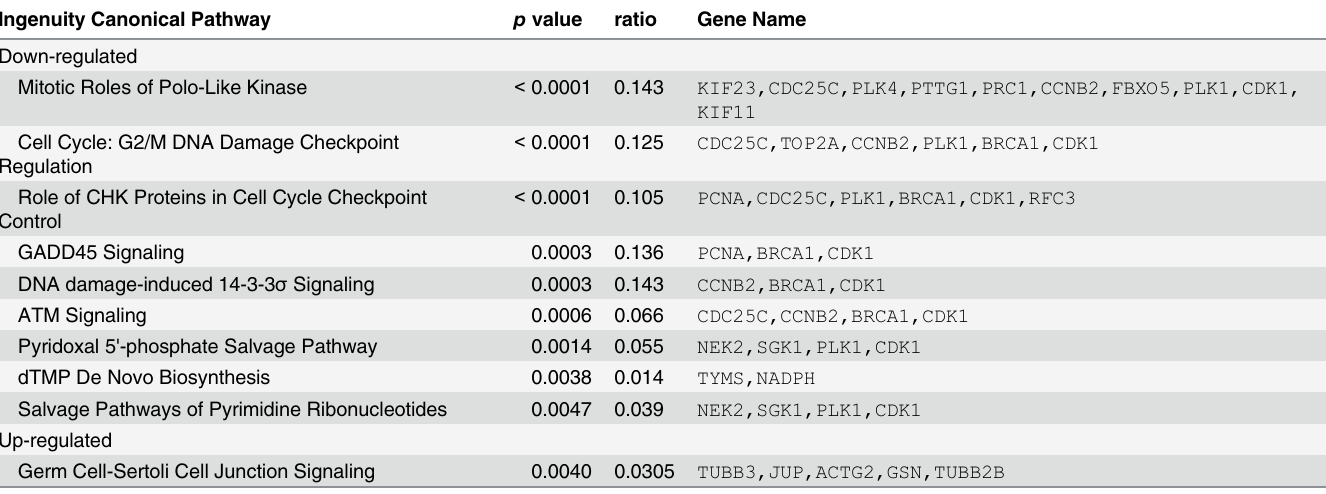
Table 1. Pathway analysis of genes in JVM-2 cells transfected with control shRNA or p53-specific shRNA consistently altered by